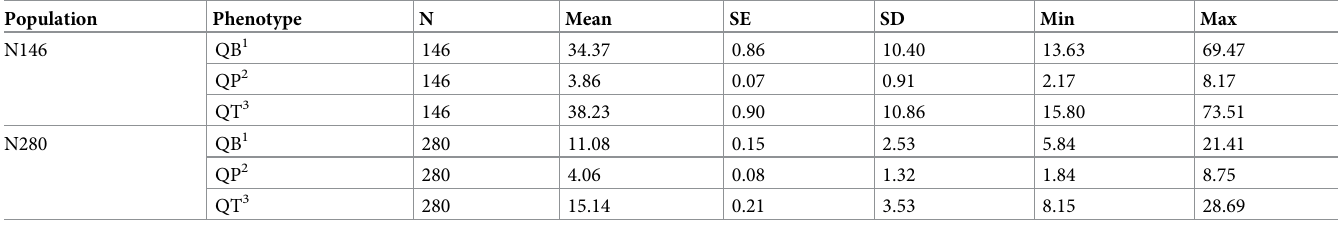
Table 5. Descriptive statistics of phenotypic data for eggshell color intensity